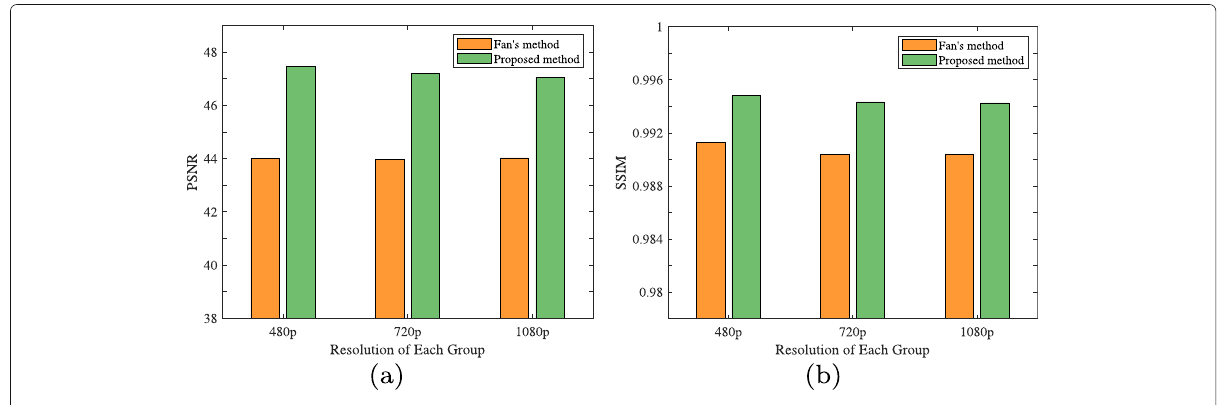
Fig. 14 a , b The PSNR and SSIM of the cover-stego pairs with resolutions of 480p, 720p, and 1080p